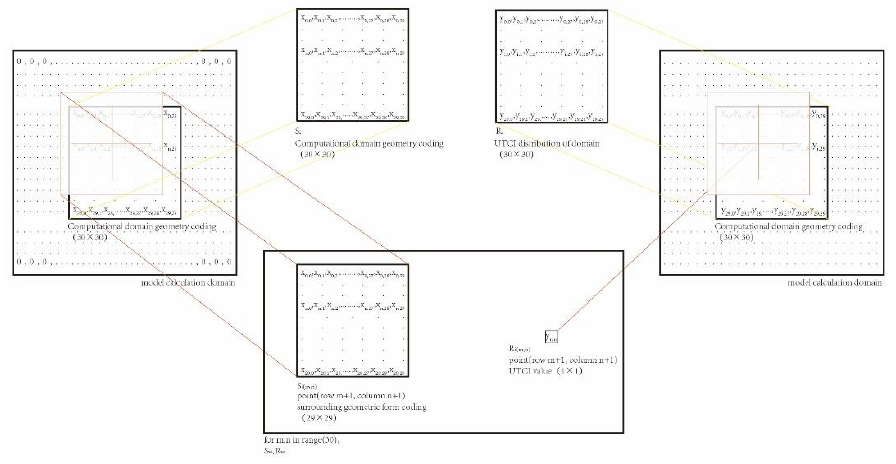
Figure 7. Data conversion rules in Group B dataset.